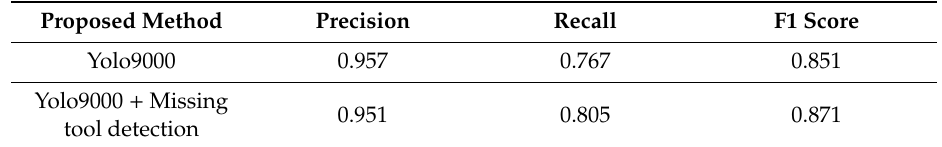
Table 4. Comparison of performance estimates of the proposed method with and without missing tool detection.